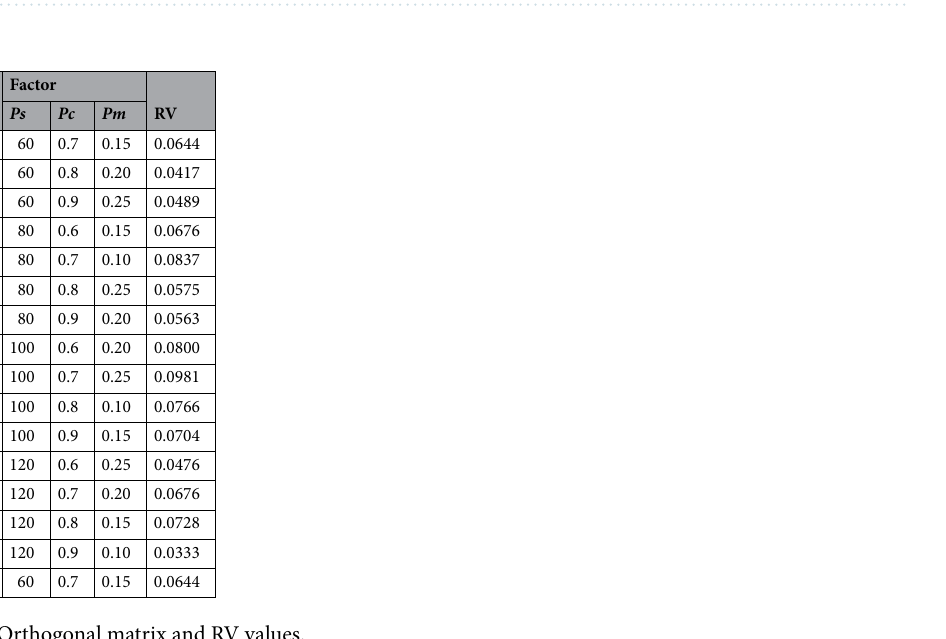
Table 6. Parameters levels.